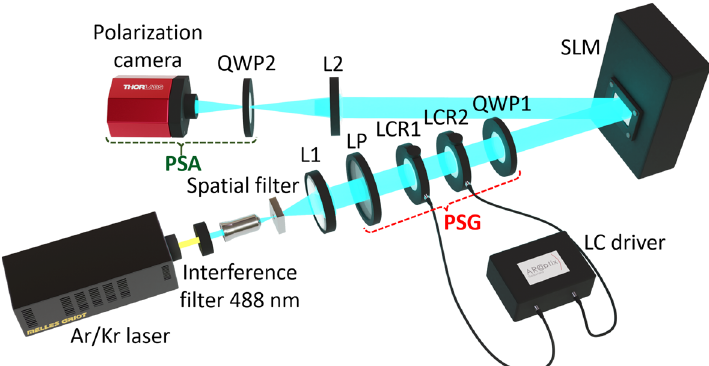
Figure 2. Schematic diagram of the Mueller imaging polarimeter in a reflection configuration ( L converging lens, LP linear polarizer, LCR liquid–crystal retarder, QWP quarter wave-plate, SLM reflective spatial light modulator, PSG polarization state generator, PSA polarization state